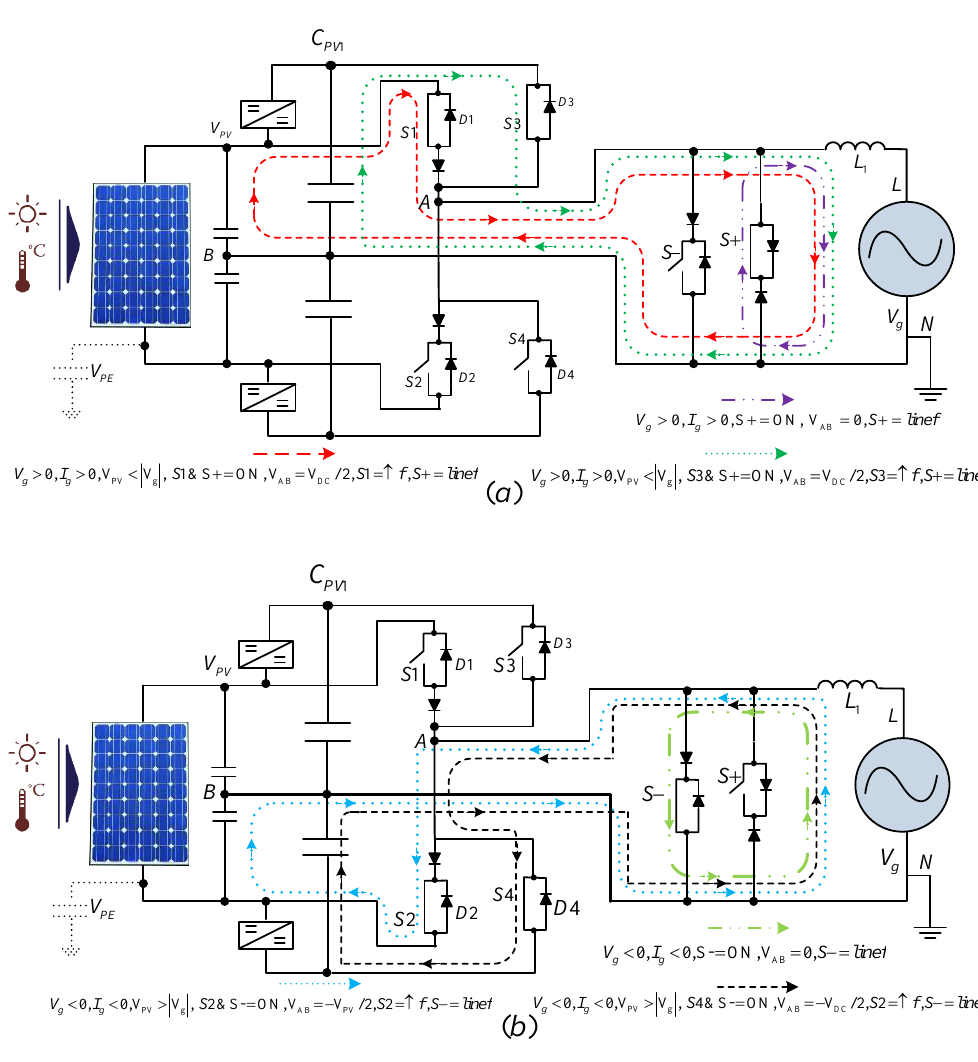
Figure 12. Switching positions of REFU (RefuSol) in case of ( a ) positive cycle and ( b ) negative cycle [29,30].